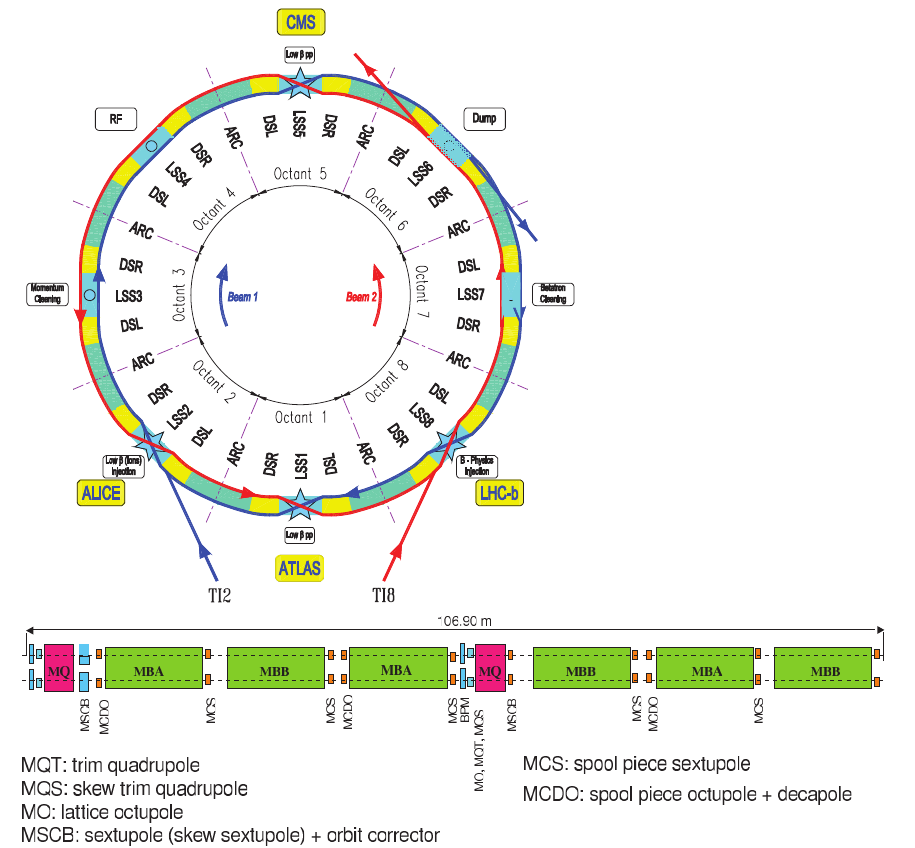
Figure 1. Upper: Layout of the Large Hadron Collider (LHC) ring (from Reference [20]). The eight- fold symmetry is visible, together with the arcs and the long straight sections. Bottom: Layout of the LHC regular cell (from Reference [20]). Six dipoles and two quadrupoles with the dipole, quadrupole, sextupole, and octupole magnets (for closed orbit, tune, chromaticity correction, and beam stabilization, respectively) are